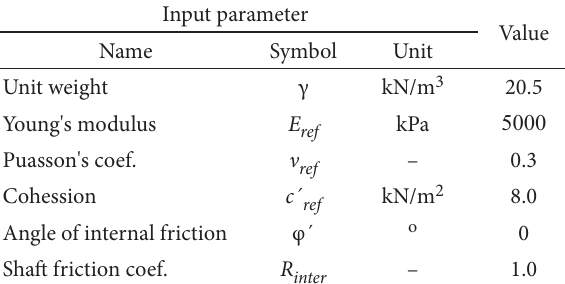
Fig. 10. Finite element mesh of model Table 7. Input parameter values for the M-C